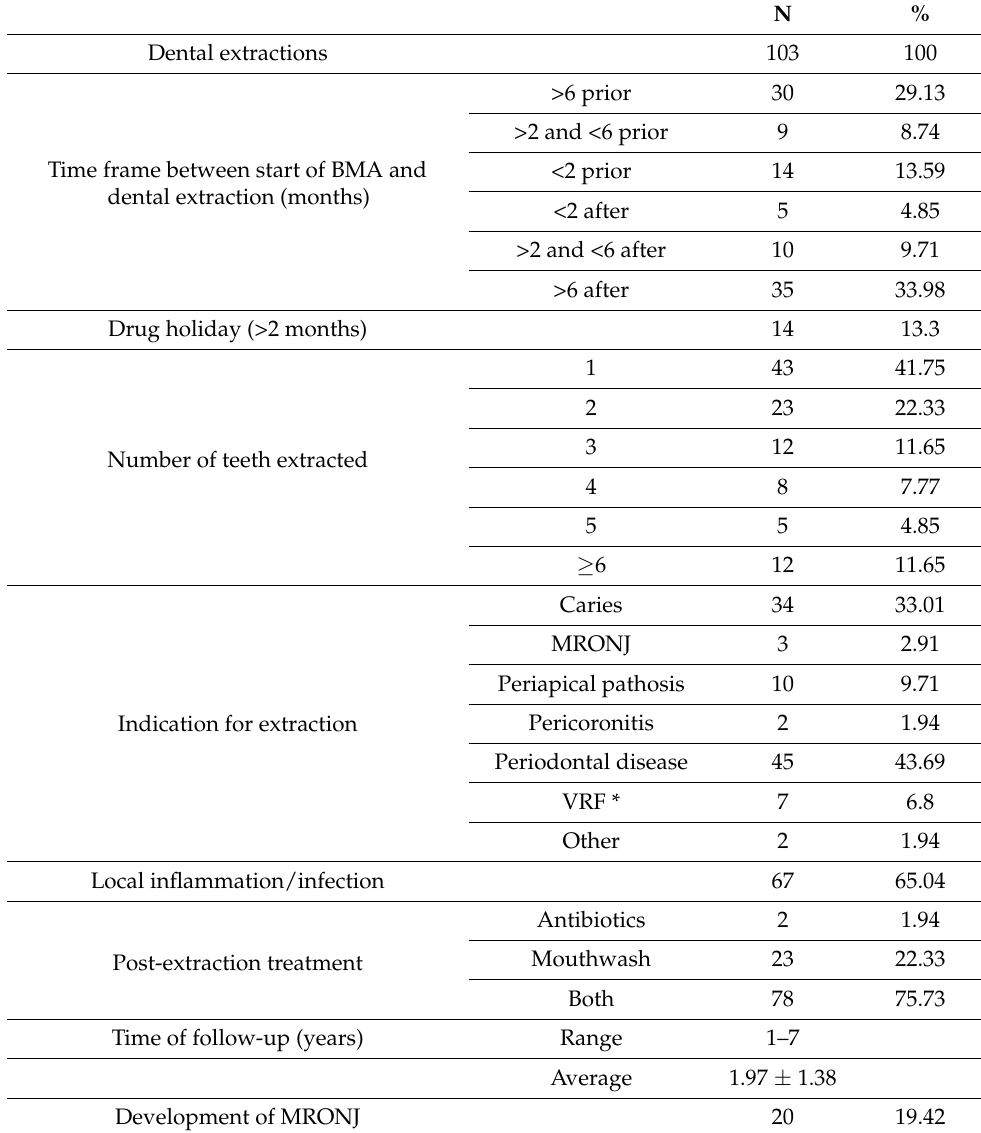
Table 2. Dental extraction